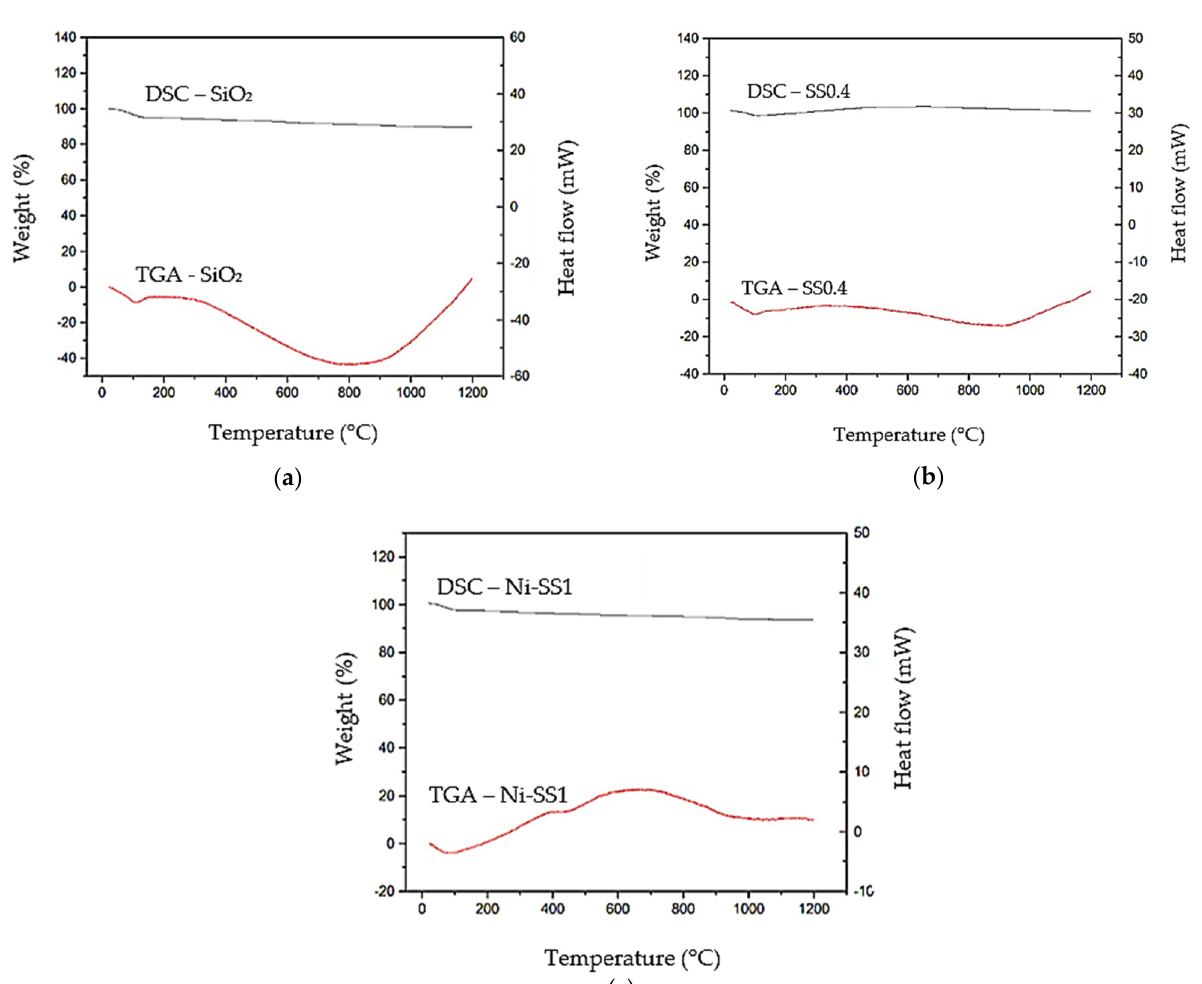
Figure 5. TG/DSC thermograms of ( a ) SiO 2 , ( b ) SS0.4, and ( c ) Ni-SS1 catalysts.